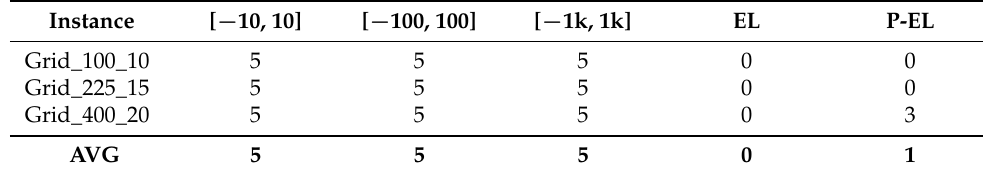
Table 2. Number of solutions with an objective function value equal to zero.